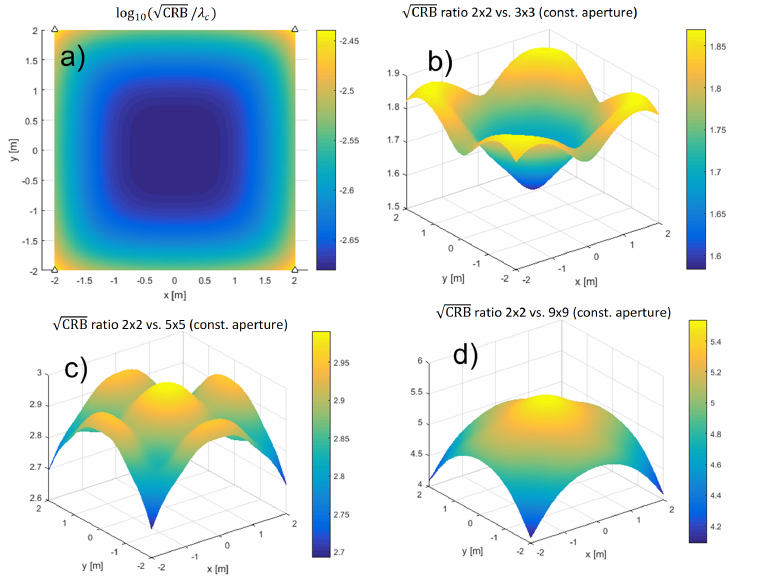
Figure 4. The 0.9 quantile of SNR 0 and N .